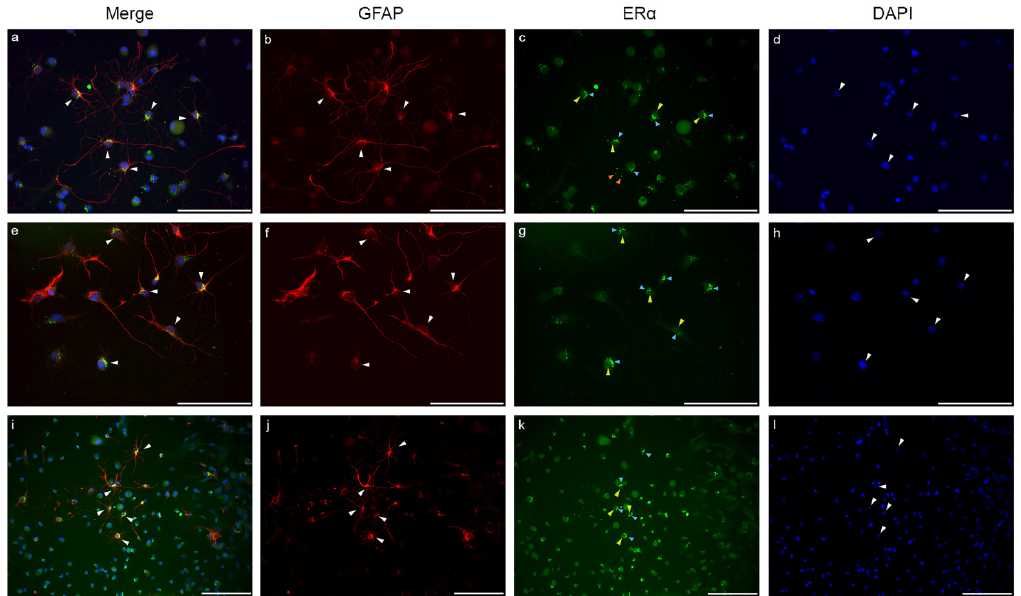
Figure 7. ER α is strongly represented in astrocytes. In GFAP (red)-labelled astrocytes ( a , b , e , f , i , j ; white arrowheads), ER α (green) is heavily expressed ( c , g , k ). The ER α signal in fibrous astrocytes shows strong and predominantly perinuclear localization in the cytoplasm ( c , g , k ; blue arrowheads), but immunopositive dots are also detectable in the processes ( c ; orange arrowheads). Nuclear ER α signals are represented as strong, unevenly distributed immunopositive dots or as a weak but even signal ( c , g , k ; yellow arrowheads). Nuclei are stained with blue ( d , h , l ). Scale bar: 100 μ m.